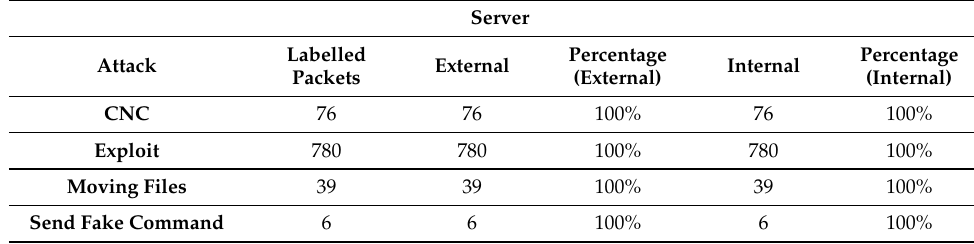
Table 11. Detected attacks towards the server.